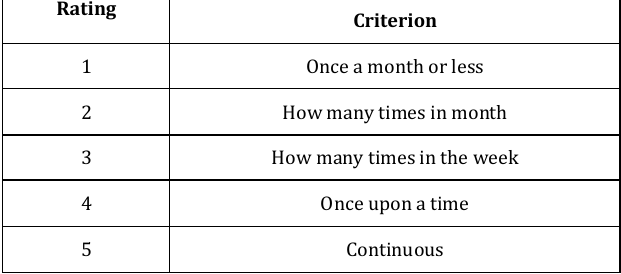
Table 2: The probability of occurrence of the environmental aspect